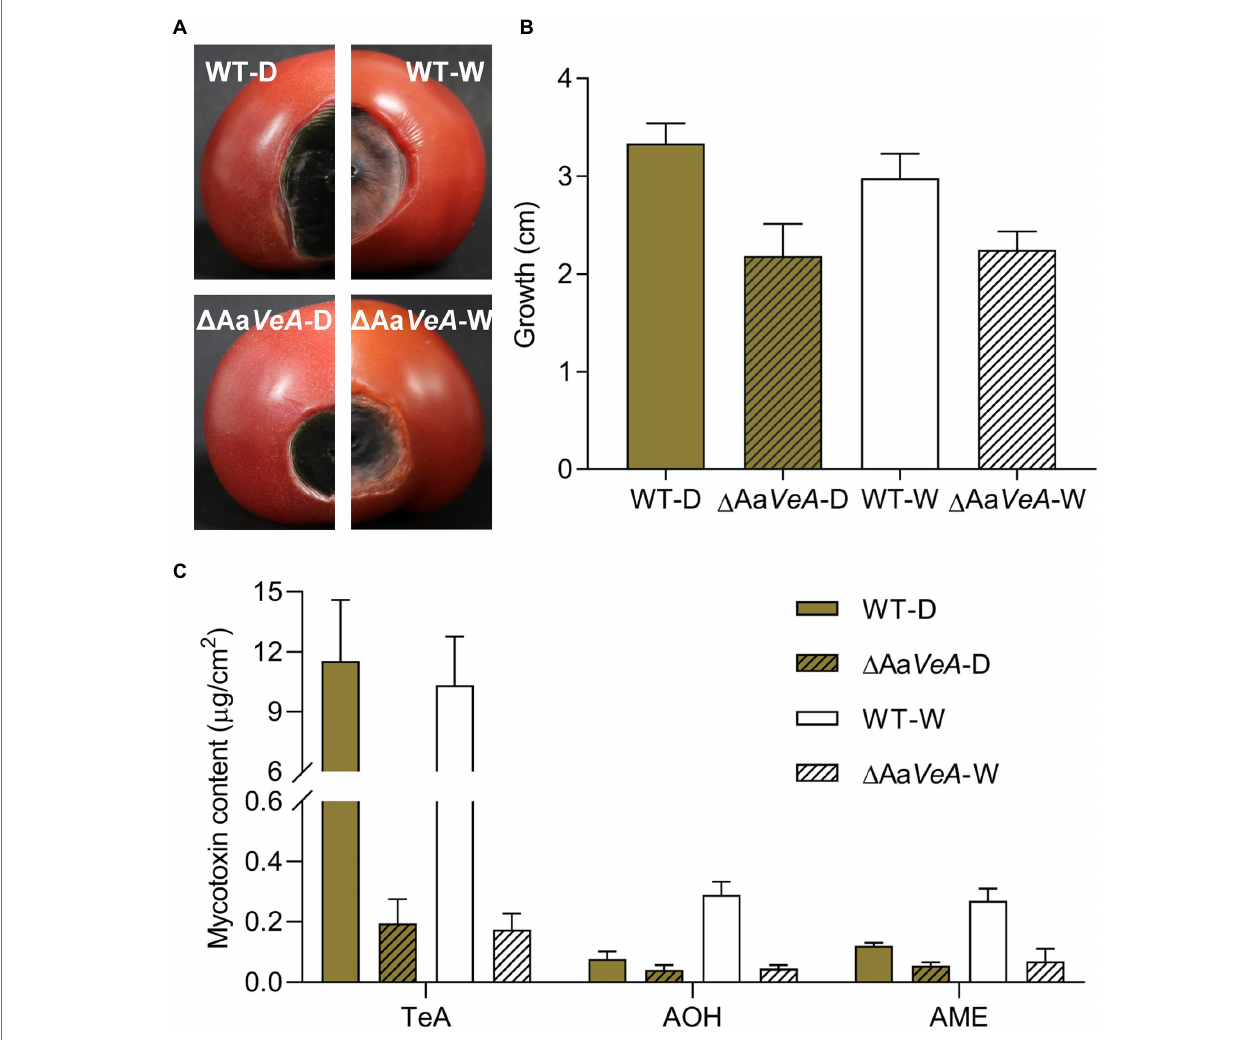
FIGURE 7 | The infection and mycotoxin production of Δ Aa VeA compared to the wild type (WT) strain on tomatoes with or without light treatment. The spore suspension of WT and Δ Aa VeA strains was separately inoculated onto tomatoes (1 × 10 5 spores/ml; 5 μ l) and cultured for 10 days at 25 ° C under dark or white light condition. (A) The diagram of tomatoes infected by WT and Δ Aa VeA strains of Alternaria alternata . (B) The growth diameter of fungal infection. (C) The mycotoxin production of Alternaria alternata on the